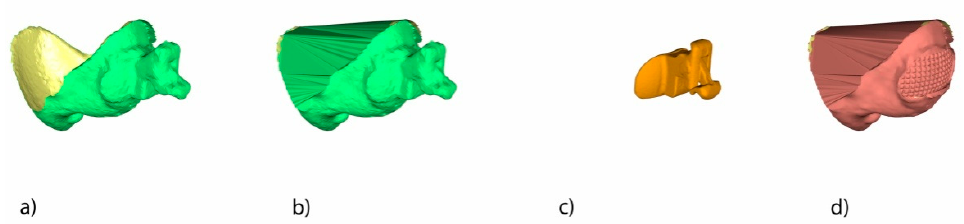
Figure 8. Proximal perspective of tooth 1.5 segmented on STL2 ( a ) and the solid mesh of tooth 1.5 on STL2. ( b ) STL5 ( c ) and the solid mesh of tooth 1.5 on STL2 with the volume of the cement used to adhere and an absent bracket ( d ).